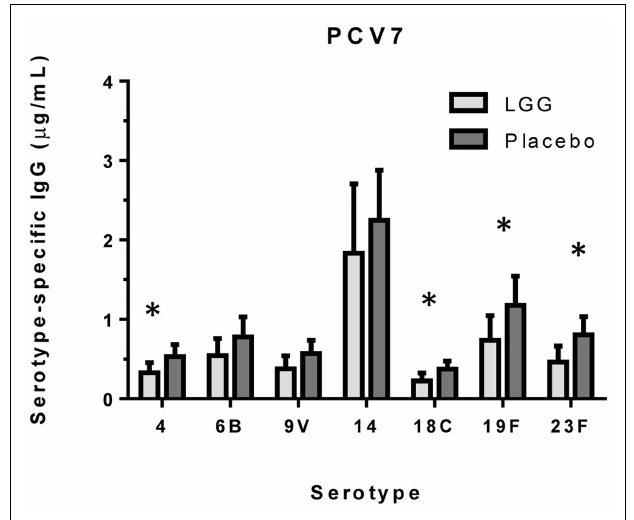
FIGURE 1 | Serotype-specific IgG levels (GMC ± 95% CI) for infants in the LGG ( N = 31) or Placebo ( N = 30) groups following PCV7 immunization . * p < 0.05 comparing LGG and Placebo treatment.